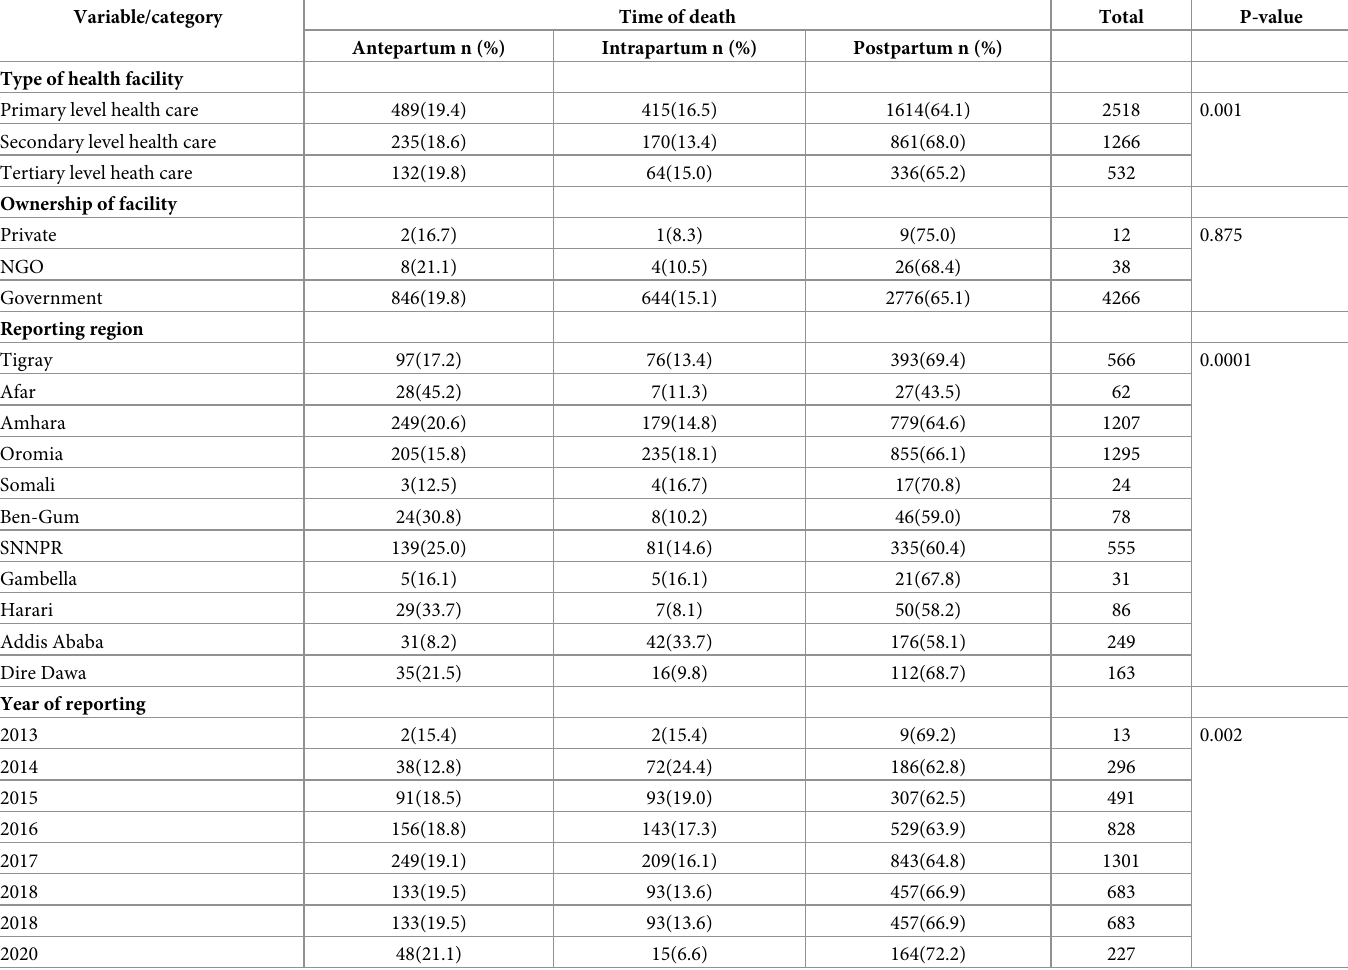
Table 1. Selected background characteristics of reporting facilities by the time of death in Ethiopia, 2020.